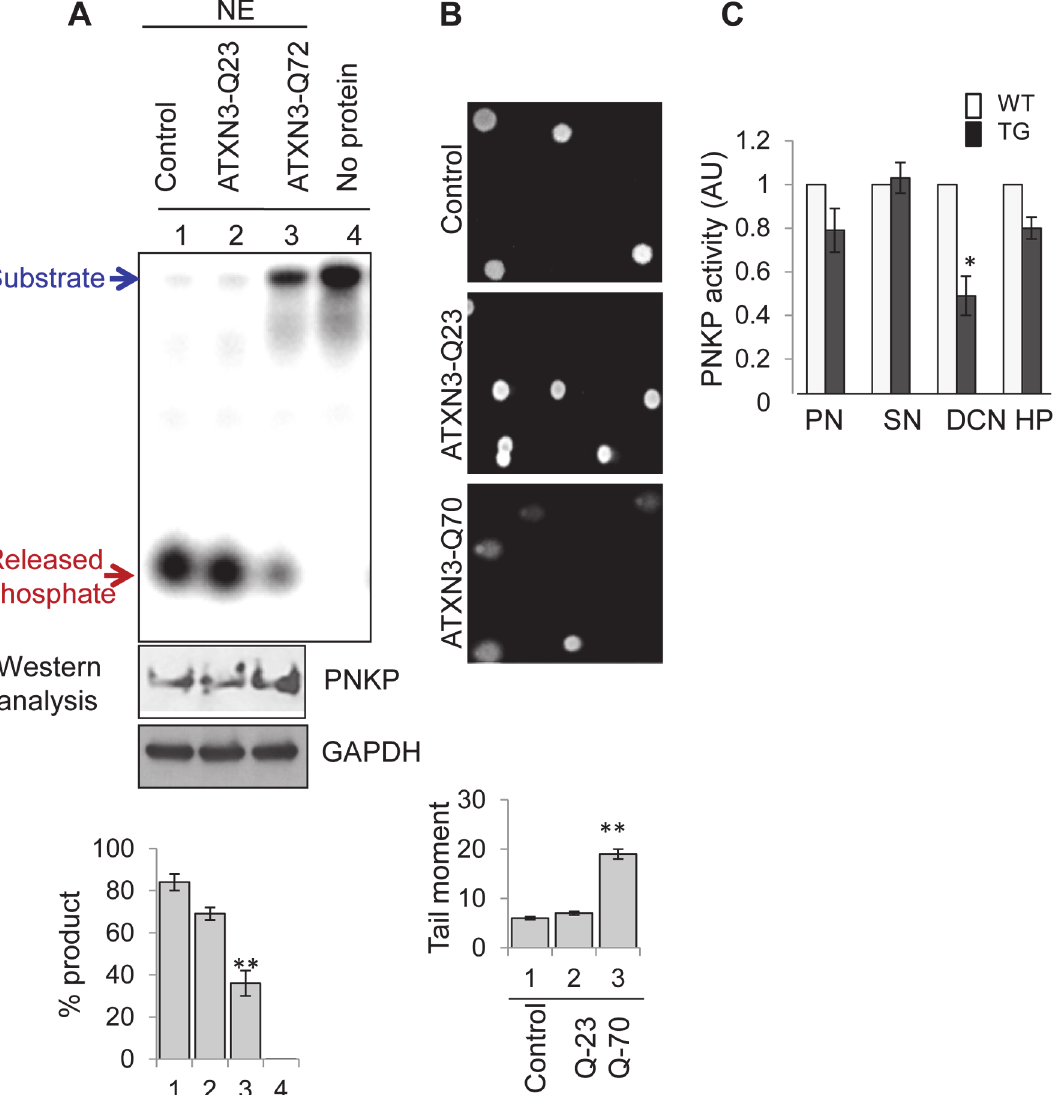
Figure 6. Decreased 3 ’ -phosphatase activity in nuclear extracts from mutant ATXN3-expressing cells, and from SCA3 mouse brain regions. (A) Upper panel, 32 P-labelled 3 ’ -phosphate-containing oligo substrate (2.5 pmol) was incubated with the NE (250 ng) isolated from rat mesenchymal (CSM14.1) cells conditionally expressing vector alone (lane 1), WT (Q-23, lane 2) or mutant ATXN3 (Q-70, lane 3). Ln 4, no protein. S: substrate, P: product (released μ g) showing PNKP expression. GAPDH (Ab from Genetex Inc.) was used as loading 32 P i ). Middle panel: Western analysis of the corresponding NE (10 control. Bottom panel: quantitation of the products (P) is represented in a histogram. (n = 3, ** = P < 0.01) (B) Comet assays showing the accumulation of DNA SBs in mutant (Q-70) ATXN3 cells. (C) Comparative (WT vs. SCA3 mice) 3 ’ -phosphatase activity in the NEs from four different brain regions. 7.5 pmol of 3 ’ -P-containing substrate was incubated at 37°C for 10 min with WT or transgenic mouse brain NE (200 ng; PN-Pontine Nuclei, SN-Substantia Nigra, DCN-Deep Cerebellar Nuclei, and HP-Hippocampus). Quantitation of the products is shown in the histogram with the age-matched WT arbitrarily set as 1 (n = 5; ** = P <